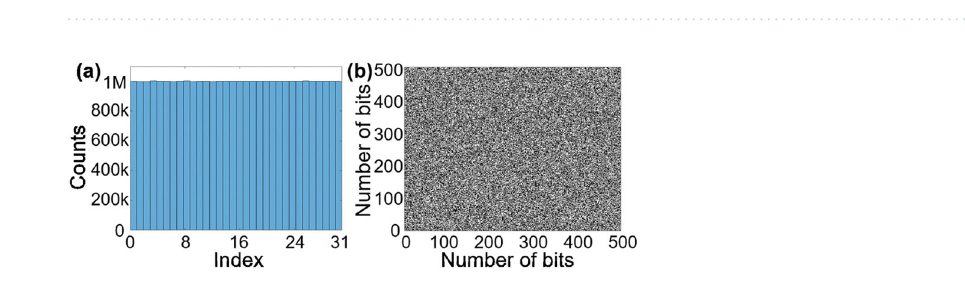
Figure 3. Autocorrelation of the first 10 µs for the raw signal (blue) and the 5 LSBs. Inset ( a ) shows that no correlation exists between the truncated bits after the first delay of 4 ps (since the ACF drops to 0 instantly), while inset ( b ) shows that taking the 5 LSBs removes all further existing correlation.